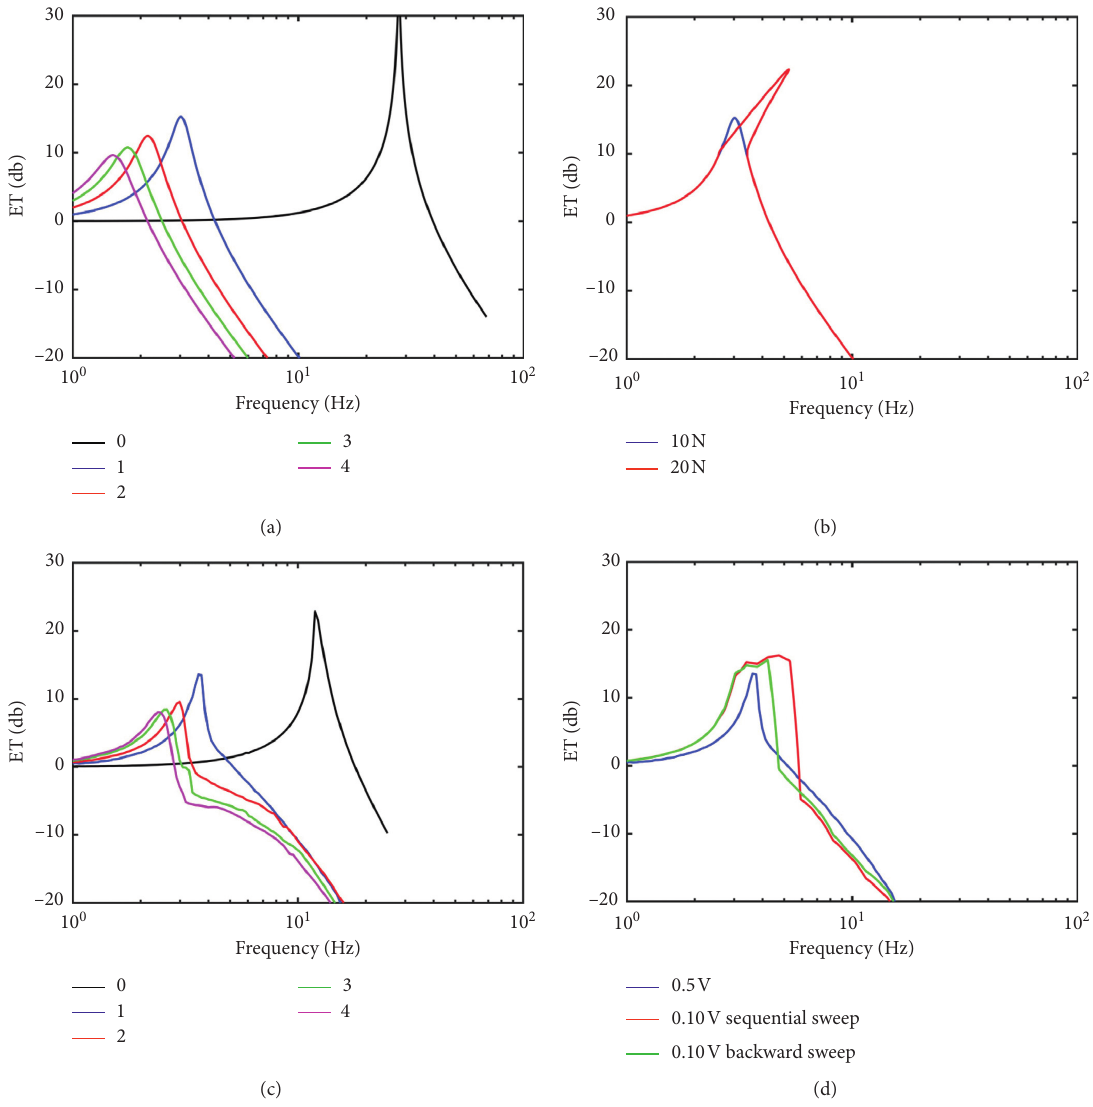
Figure 4: ETs of the MMSI vibration isolation system. (a) Theoretical ETs of the system with different number of accumulators under the same excitation force (10N). (b) Theoretical ETs of the system with one accumulator under different excitation forces (10N and 35N). (c) Experimental ETs of the system with different number of accumulators under the same excitation force (0.5V). (d) Experimental ETs of the system with one accumulator under different excitation forces (0.5V and